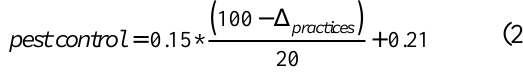
Table 1 for a comparison of the farmers’ behaviors. Two key features distinguish the different types of farmers: